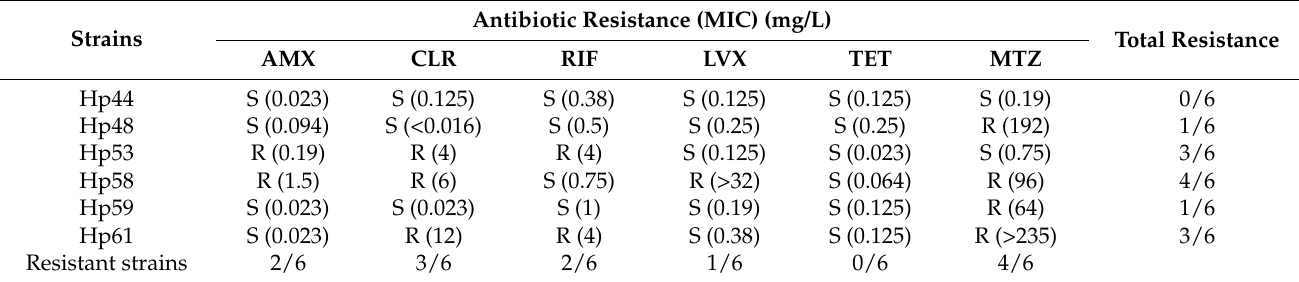
Table 1. Antibiotic resistance and MIC profile of H. pylori strains isolated from gastric biopsies.